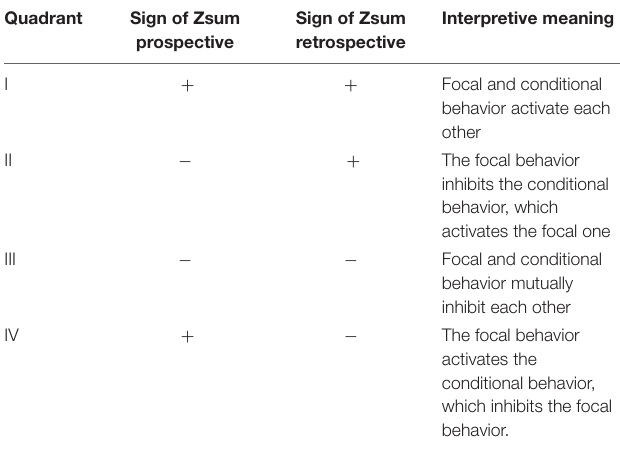
TABLE 1 | Interpretation of polar coordinate maps.